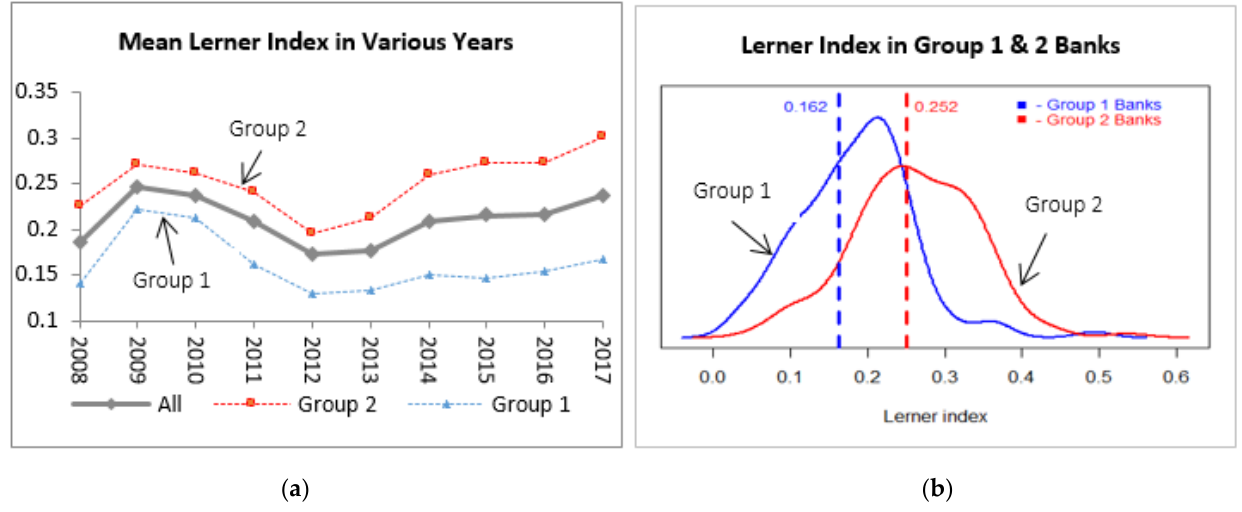
Figure 3. The average Lerner index for group 1 and group 2 Vietnam banks for the period 2008 to 2017. Source: author’s computation.